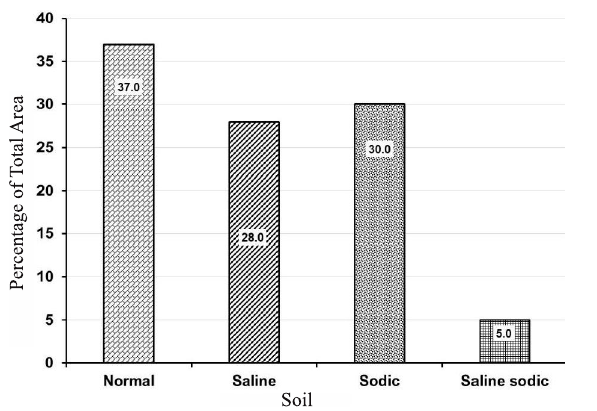
UNCLASSIFIEDFIG. 12. PERCENTAGE OF TOTAL COMMAND AREA OF THE DANASTAR WAH UNDER NORMAL, SALINE, SODIC AND SALINE-SODIC SOILS